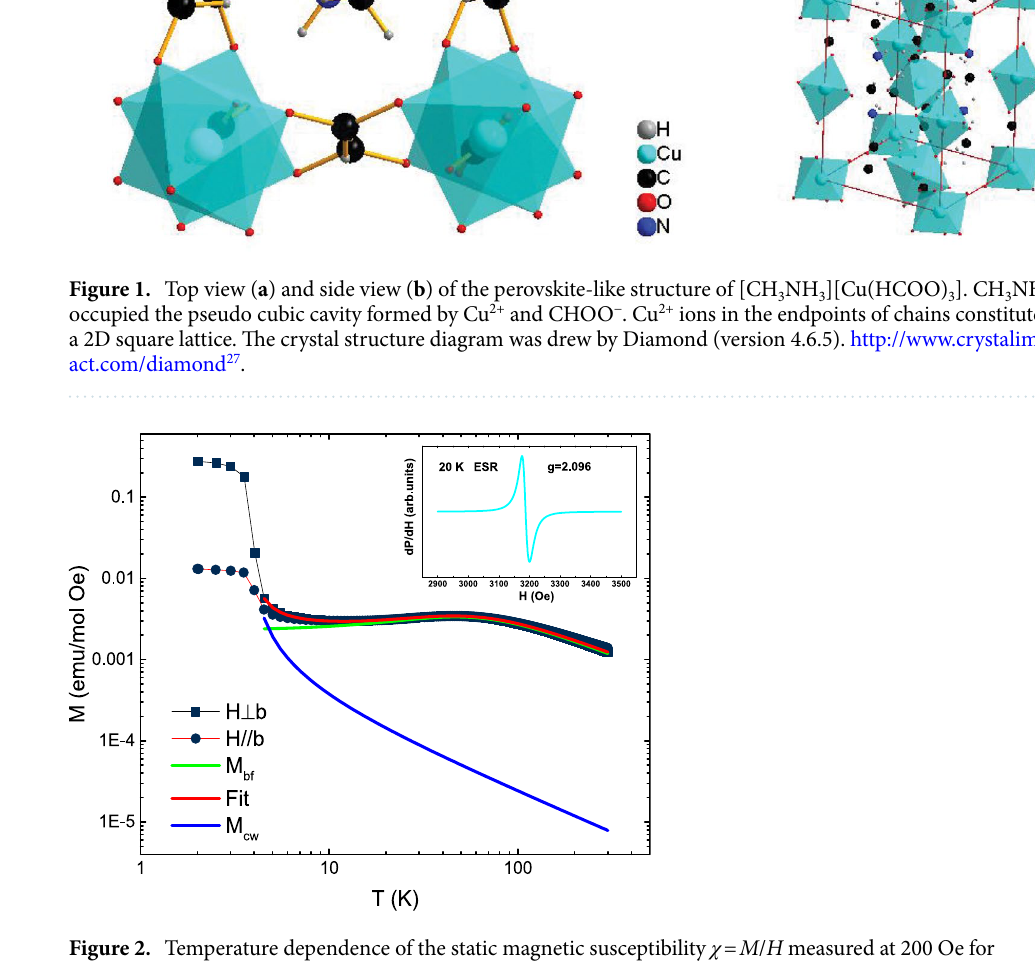
Figure 2. Temperature dependence of the static magnetic susceptibility χ = M / H measured at 200 Oe for H parallel and vertical to b axis above 4 K. Static magnetic susceptibility χ = M / H of MACuF, at B = 200 Oe. The red line represents the fit by Eq. (2). The green line is contribution of χ chain . The blue line is Curie–Weiss paramagnetic susceptibility. The inset shows the ESR spectra at 20